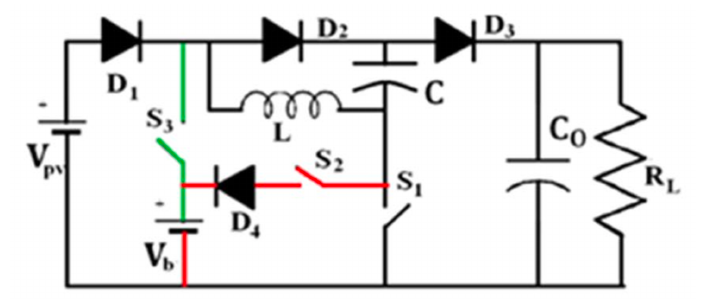
Figure 24. The DIDC topology presented in